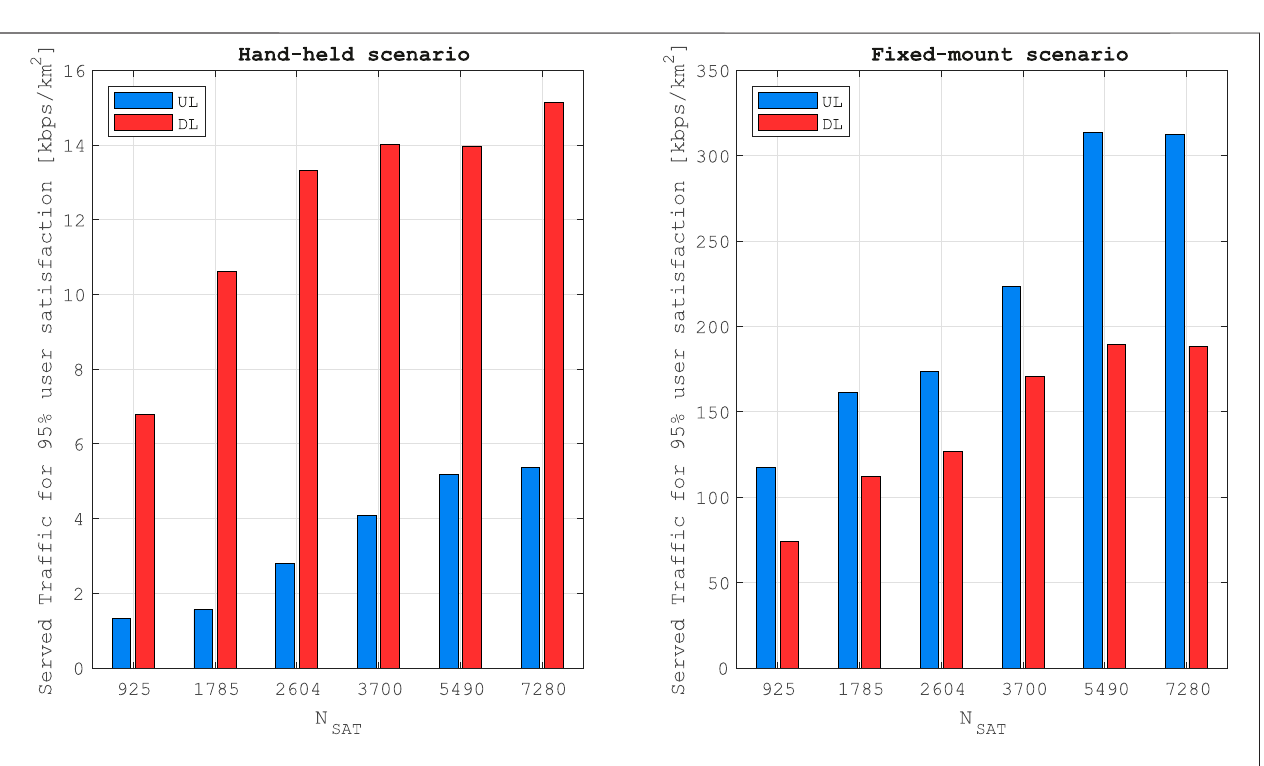
FIGURE 8 | Capacity (served traf fi c at 95% service coverage) for different NTN scenarios.